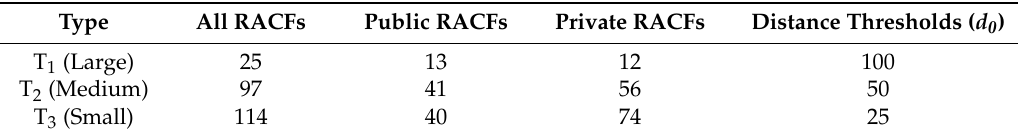
Table 1. Numbers and service area of different types of RACF in Wuhan,